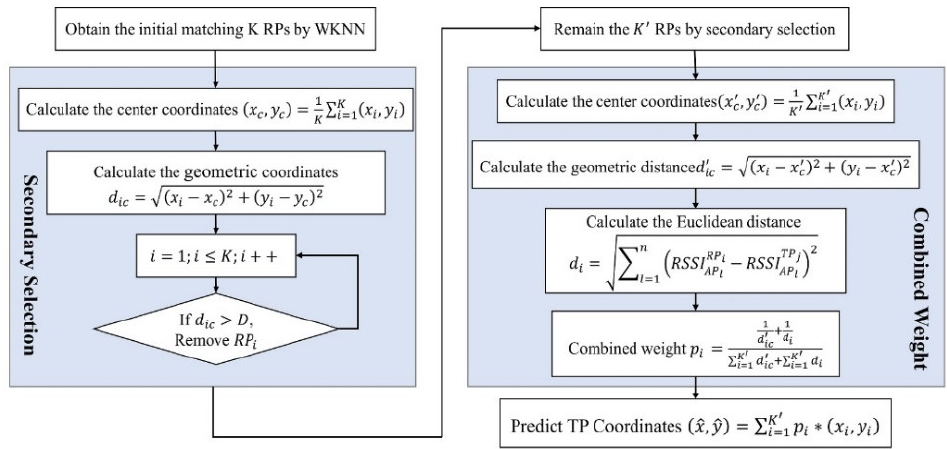
Figure 5. The flow chart of the improved WKNN.